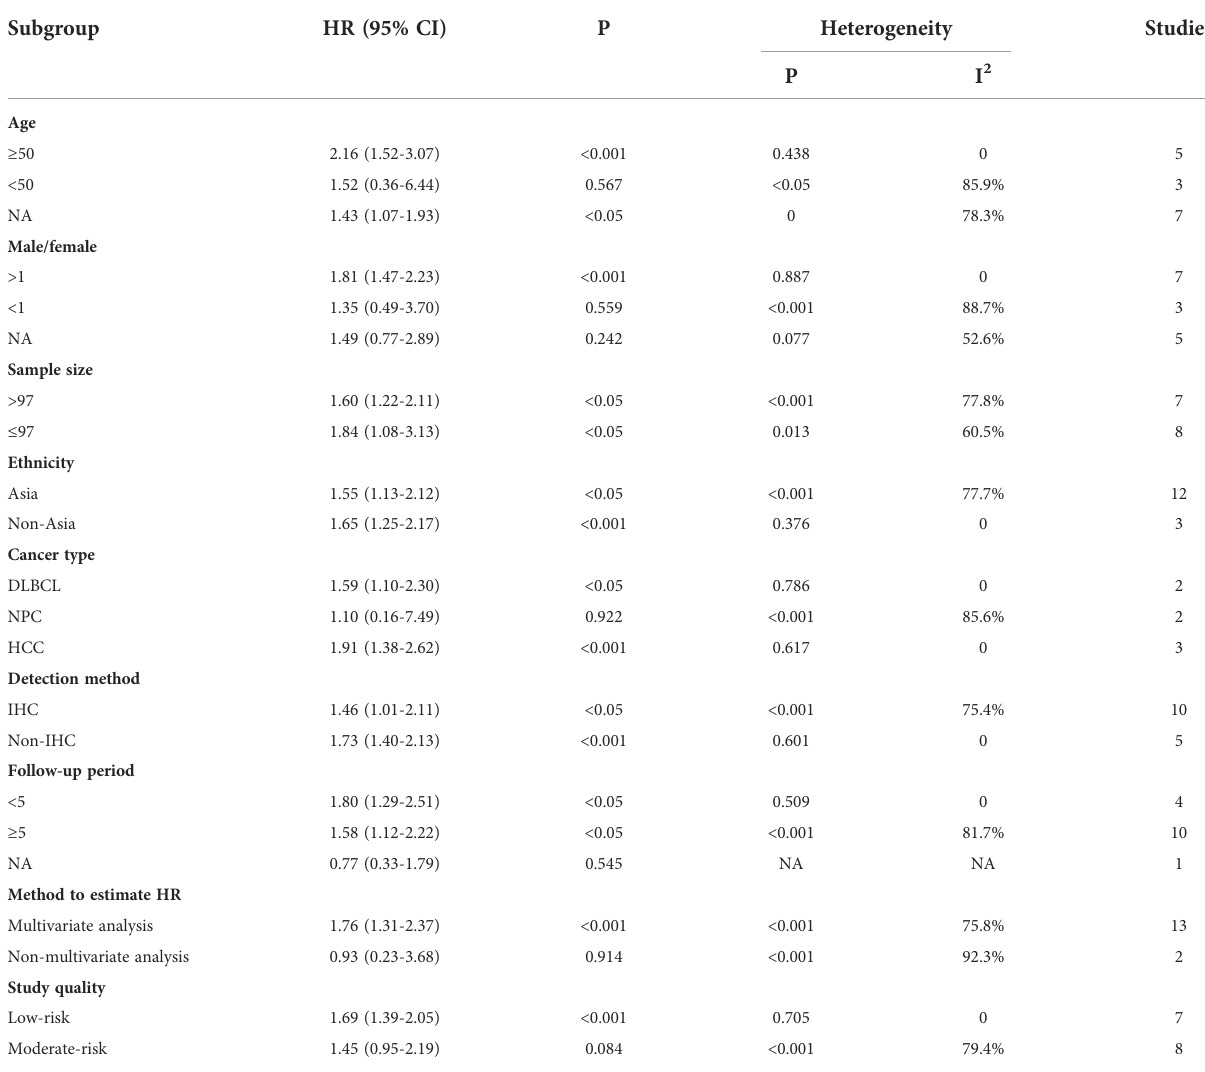
TABLE 2 Subgroup analysis of OS included in the